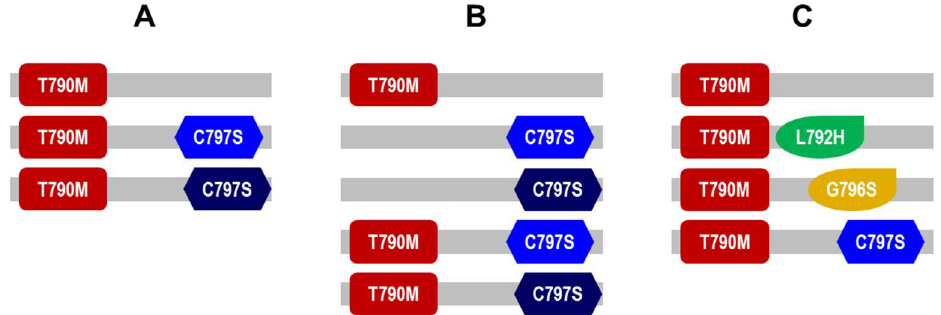
Figure 2. Schematic representation of EGFR and PIK3CA allelic variants in plasma samples of select patients after osimertinib second line treatment. ( A ) Three distinct alleles: T790M, T790M + C797S (c.2389T > A,) T790M + (C797S c.2390 G > C) ( B ) Five distinct alleles: T790M, C797S (c.2389T > A), C797S (c.2390 G > C), T790M + C797S (c.2389T > A), T790M + C797S (c.2390 G > C) ( C ) Four distinct alleles: T790M, T790M + PIK3CA (L792H), T790M + PIK3CA (G796S), T790M + C797S (c.2389T >